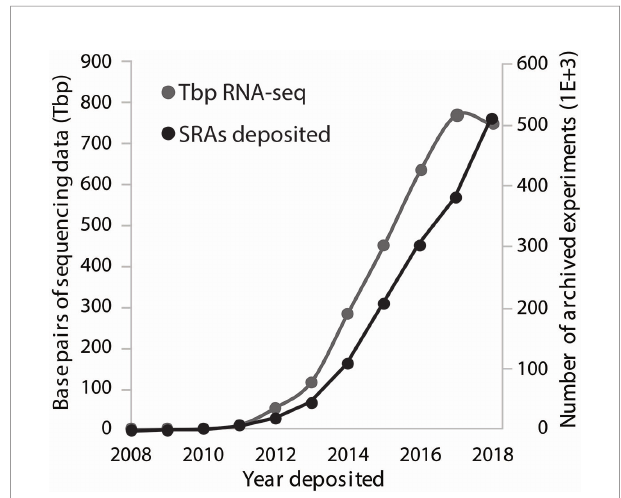
FIGURE 1 | RNA-sequencing (RNA-seq) data deposited on National Center for Biotechnology Information (NCBI's) sequence read archive (SRA). SRA run information associated with transcriptomic analyses was downloaded and sorted by year deposited. Tera base pairs (Tbp, 1E+12) of RNA-seq data deposited is shown with the gray line and plotted on the left y-axis. Thousands of experiments deposited, per year, is shown with the black line on the right